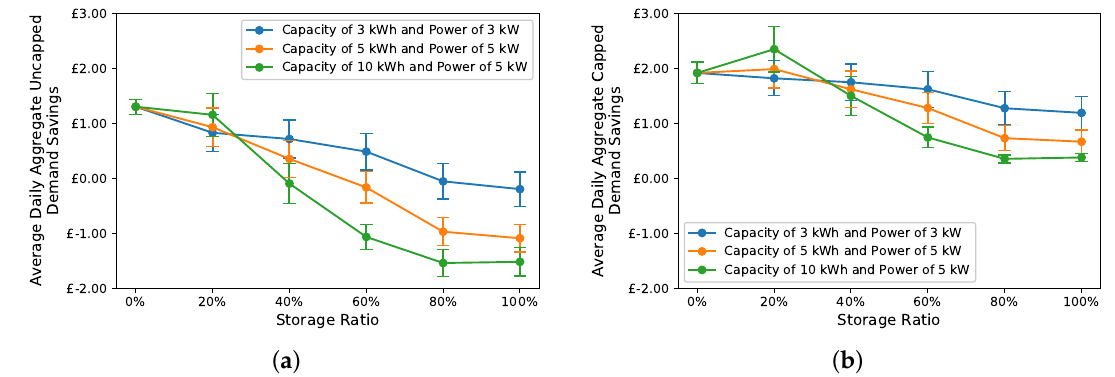
Figure 12. Comparison between average daily DS K and (cid:100) DS K with storage variations. The error bars represent 95% confidence intervals. ( a ) Average daily DS K . Capacities 5 and 10 kWh with 60% or more prosumers with storage, decrease DS K to below zero, which is more significant with larger capacities. ( b ) Average daily (cid:100) DS K . Increasing the storage capacity or the ratio of prosumers with storage decreases (cid:100) DS K , but it never reaches negative levels.